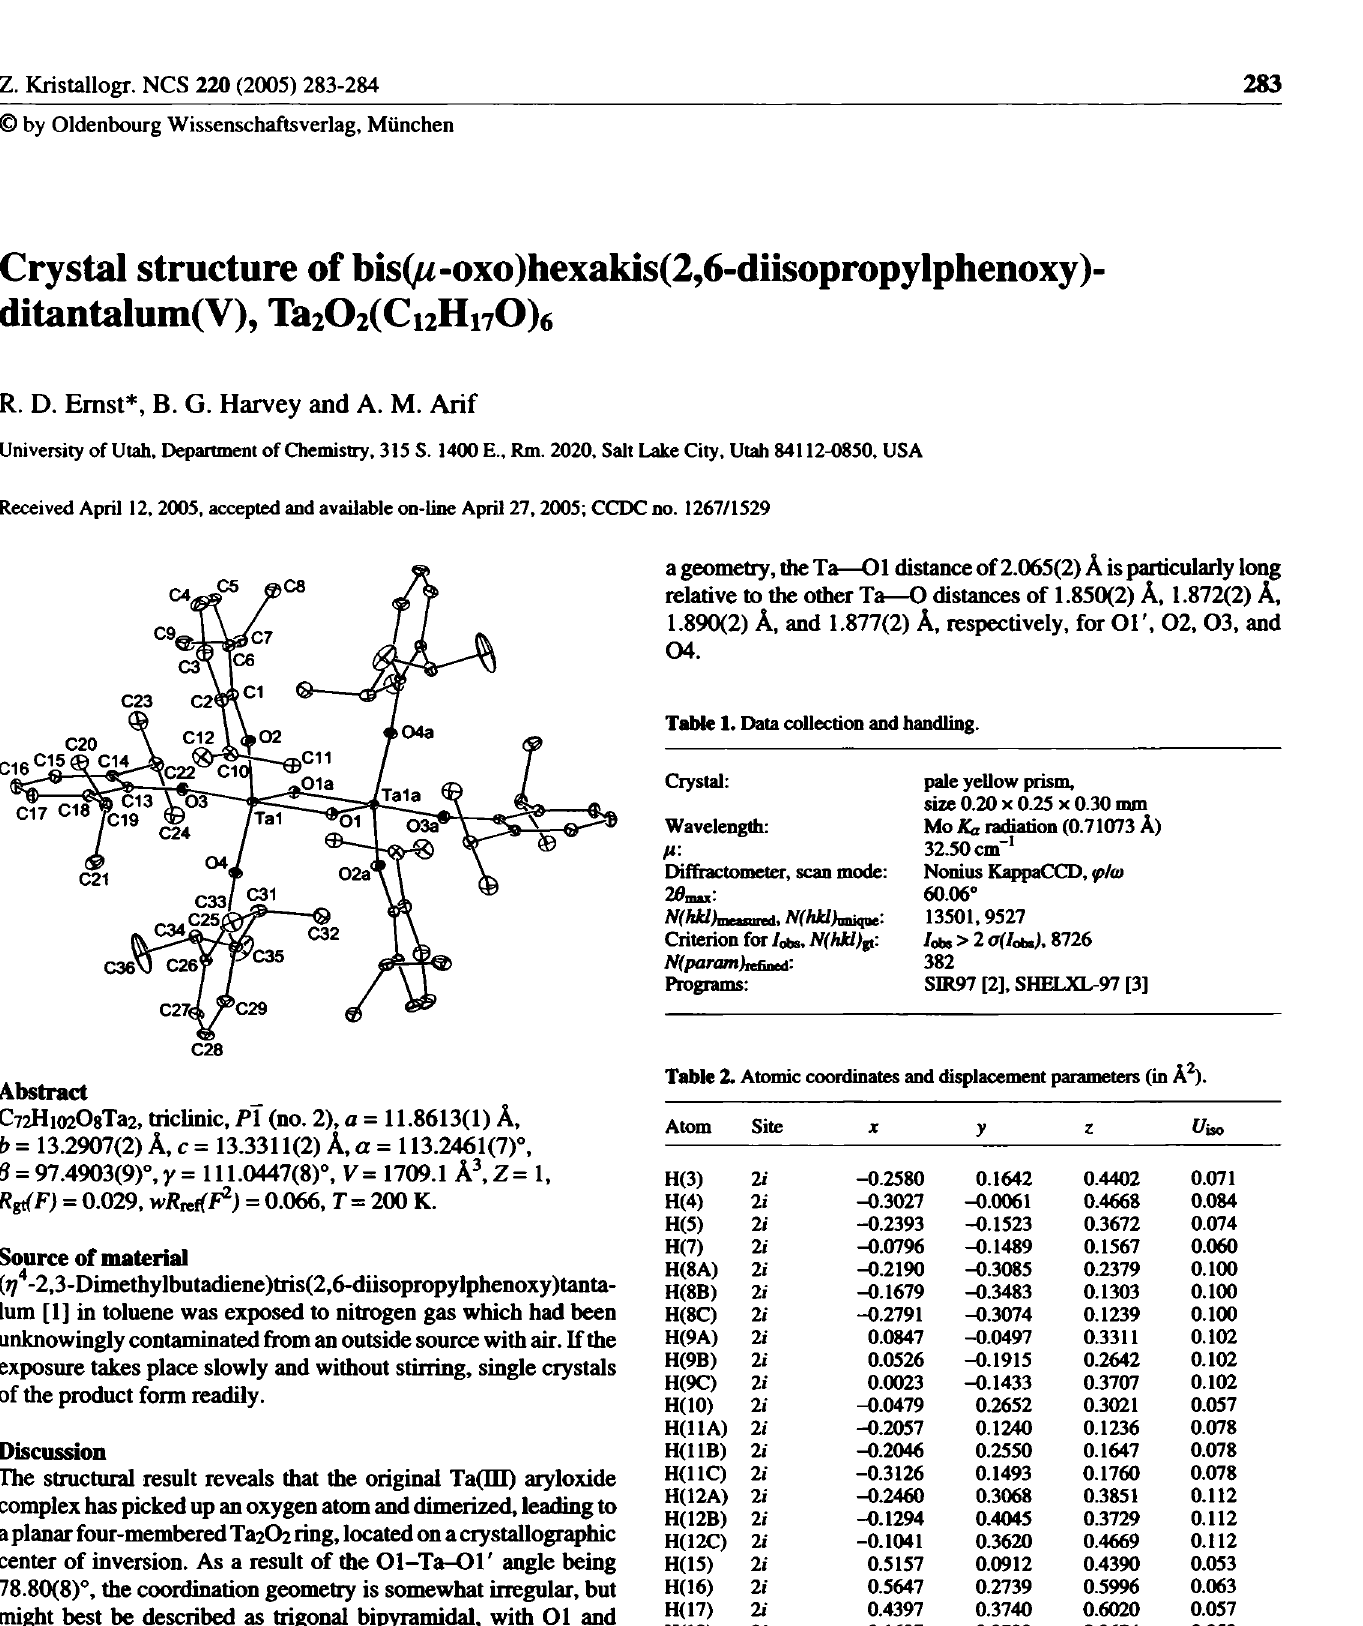
Table 2. Atomic coordinates and displacement parameters (in A 2